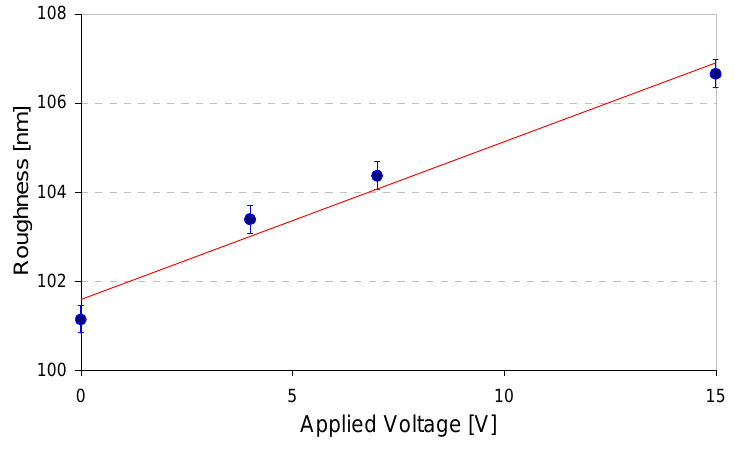
Figure 4. Roughness change with the applied voltage.